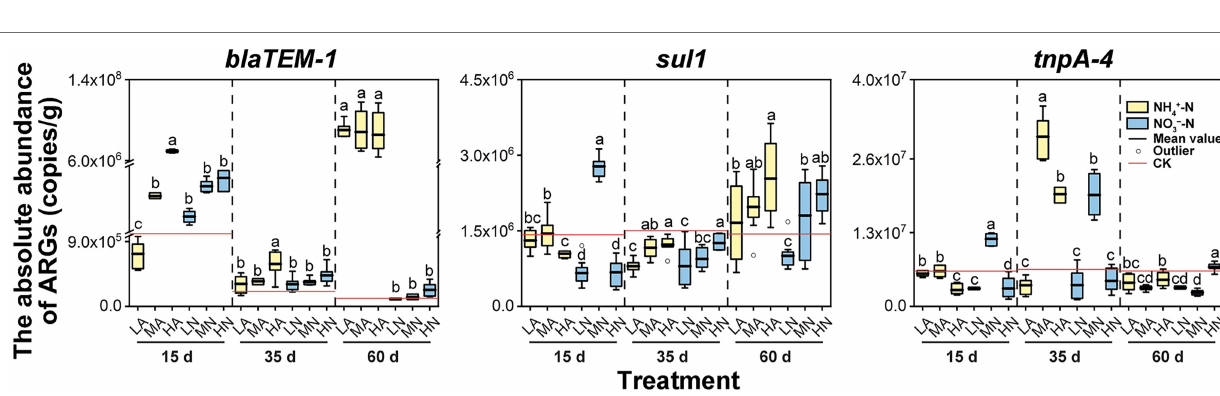
FIGURE 2 | The absolute abundance of ARGs ( blaTEM-1 , sull , and tnpA-4 ) in the soil at three periods (15, 35, and 60 days) with nitrogen treatments: 25 mg kg − 1 NH 4+ -N (LA), 100 mg kg − 1 NH 4+ -N (MA), 200 mg kg − 1 NH 4+ -N (HA), 25 mg kg − 1 NO 3 − -N (LN), 100 mg kg − 1 NO 3 − -N (MN), and 200 mg kg − 1 NO 3 − -N (HN). Errors bars represent standard deviations of triplicate samples. Different lowercase letters above indicated significant among treatments at p <